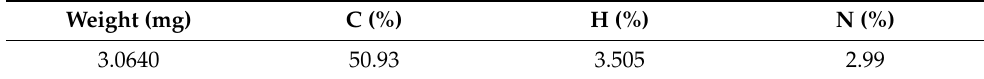
Table 1. The element analysis of Ala-C 60